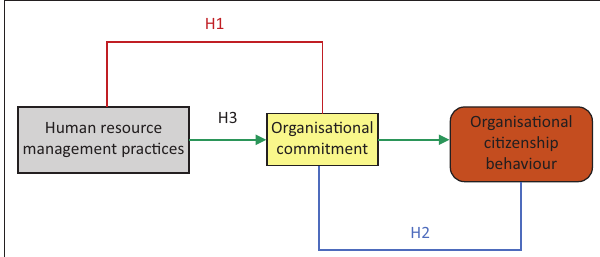
FIGURE 1: Conceptual framework of the